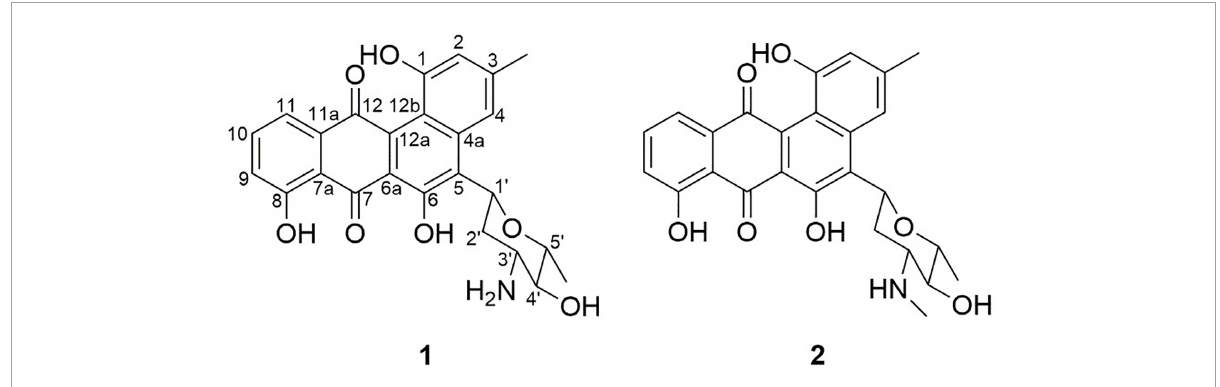
FIGURE3 Structures of compounds 1 and 2 isolated from Streptomyces CS-7. The compounds (1: mayamycin B and 2: mayamycin) were isolated in this research and elucidated structurally using HRESIMS and NMR techniques.